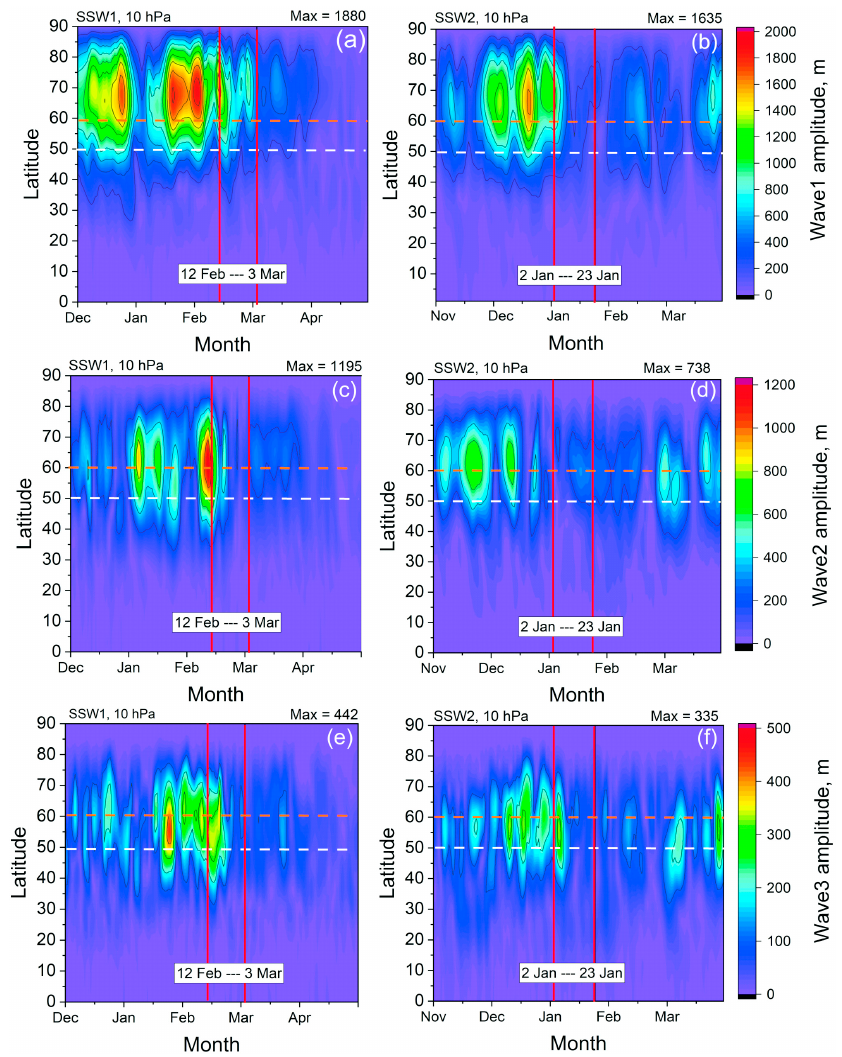
Figure 3. Latitude–time cross-section of the amplitudes of planetary waves 1, 2, and 3 at 10 hPa in Northern Hemisphere (NH) for: ( a , c , e ) December 2017–April 2018 and ( b , d , f ) November 2018–March 2019 by MERRA-2 data [41]. Red vertical lines mark the SSW start and end dates. Red (white) dashed horizontal lines mark the mean vortex edge latitude of 60° N (MWR site latitude 50°N).